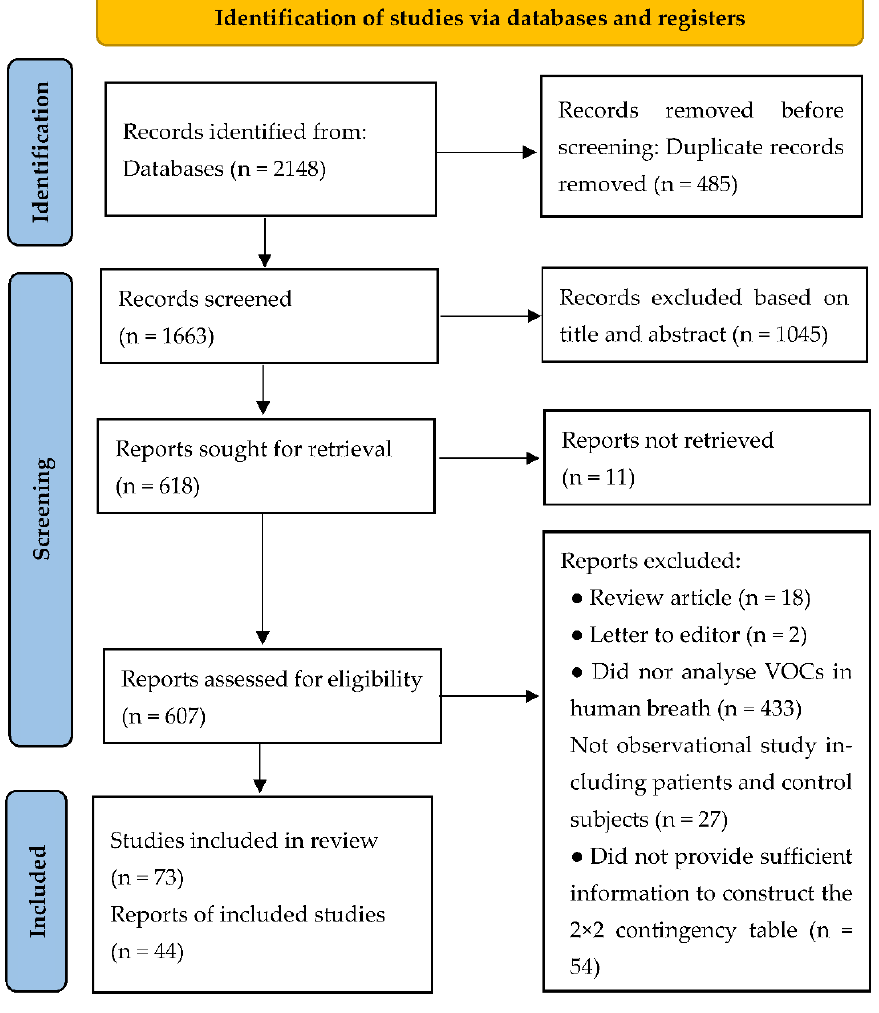
Figure 1. PRISMA flow chart of literature search.